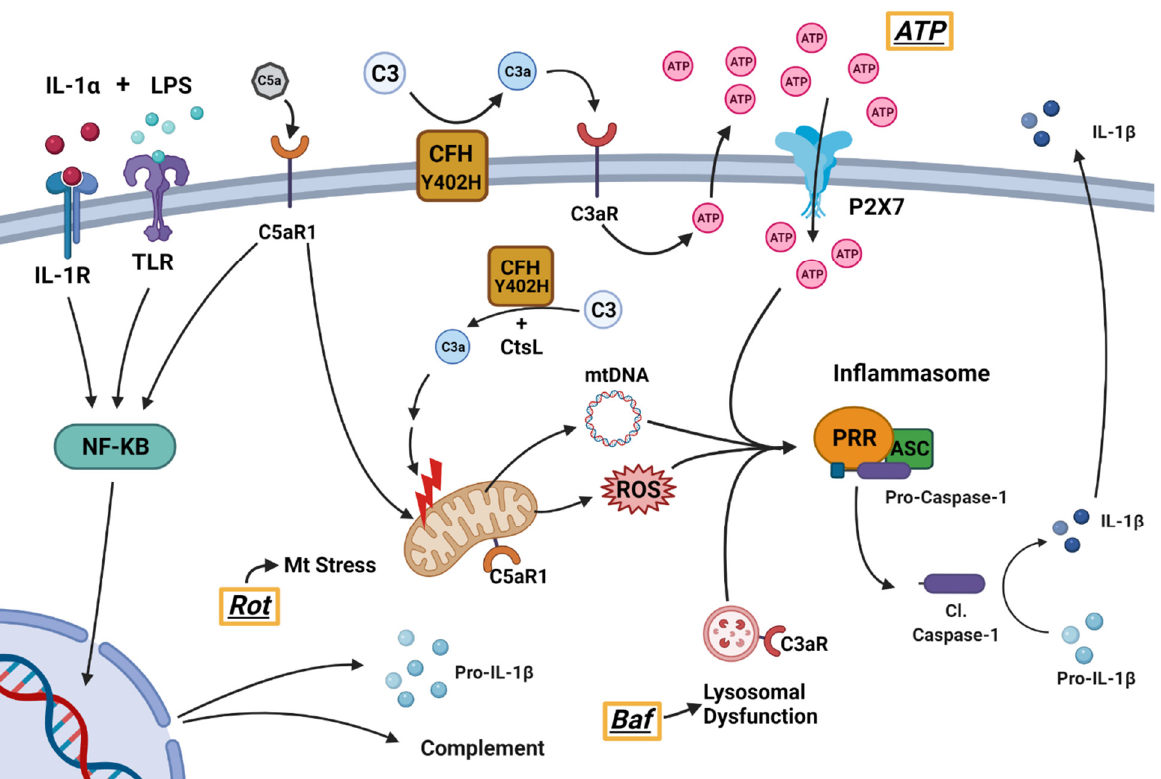
Figure 1. Model of inflammasome activation and complement pathway contributions. Priming via IL-1R and TLR, activated by IL-1α and LPS, leads to NFκB-mediated expression of pro-IL-1β and complement genes. The inflammasome is activated via a number of signals. In this study, we utilized rotenone (Rot) to induce mitochondrial damage, which leads to mtDNA release and generation of ROS. Bafilomycin A (Baf) was used to induce lysosomal dysfunction. ATP was used to stimulate P2X7 receptors. Dysregulation of the complement pathway by CFH Y402H leads to an accelerated turnover of C3 into C3a, which can contribute to mitochondrial damage and activation of C3aR. C3aR activation on the cell’s membrane leads to ATP efflux and subsequent activation of P2X7 receptor. C5aR1 may also contribute to inflammasome pathway activation via NF-κB, as well as mitochondrial damage and intracellular ROS accumulation. These signals ultimately lead to formation and activation of the inflammasome, which is a multi-subunit complex containing a PRR, ASC, and pro-Caspase-1. The assembly of the inflammasome triggers the cleavage of Pro-caspase-1 to cleaved-Caspase-1 (Cl. Caspase-1), which proteolytically activates pro-inflammatory cytokine IL- 1β. IL-1β is secreted, leading to inflammation. LPS = lipopolysaccharide, ROS = reactive oxygen species, PRR = pattern recognition receptor, ASC = apoptosis-associated speck-like protein containing a caspase activation and recruitment domain, IL-1β = Interleukin-1β, CSTL = cathepsin L.